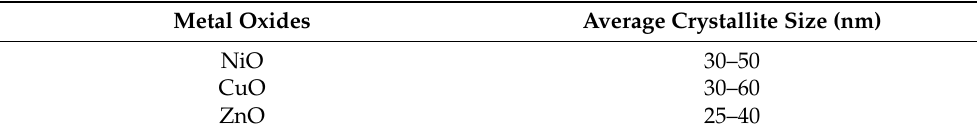
Table 1. Average crystallite size of the metal oxides synthesized via the green method.